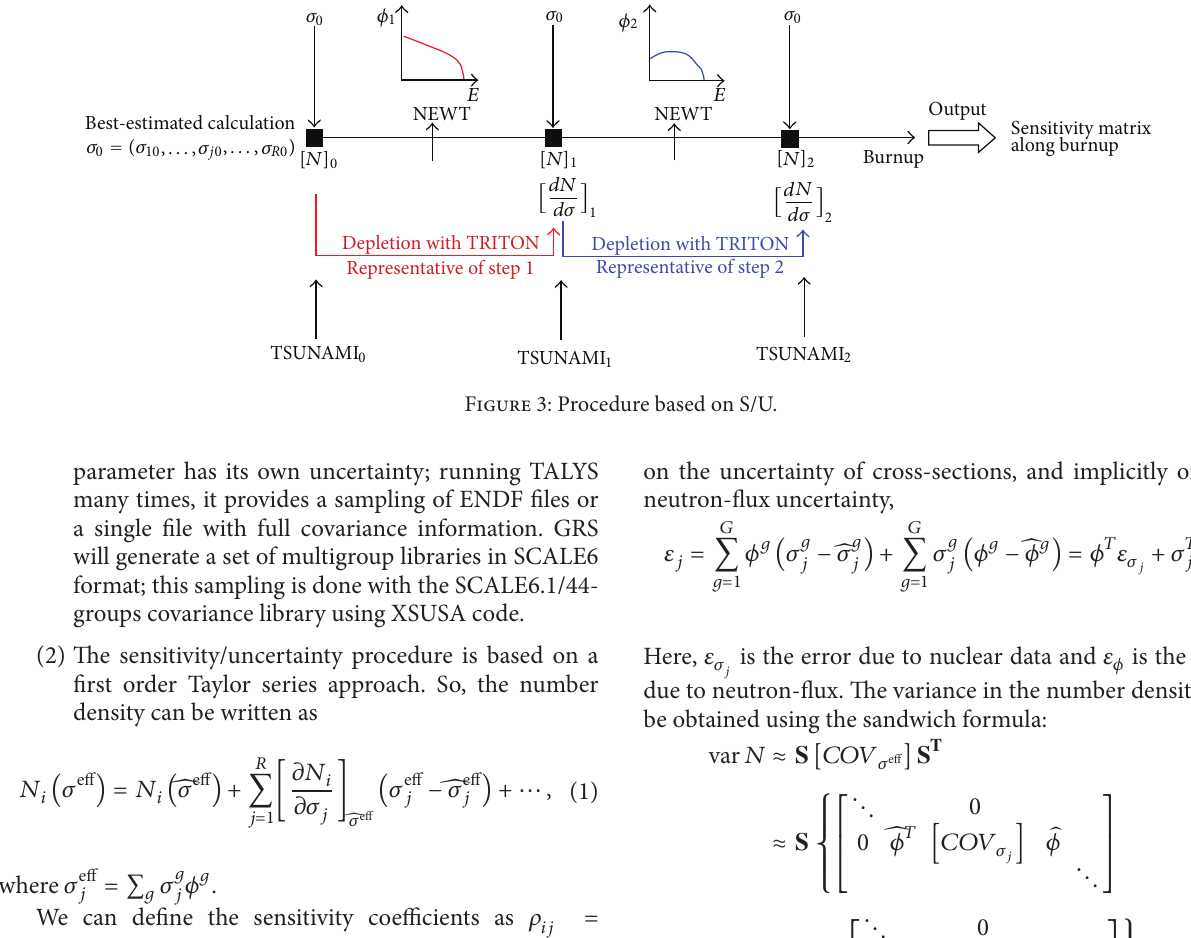
F 2: Simultaneous random sampling of the PDF of all the input parameters.